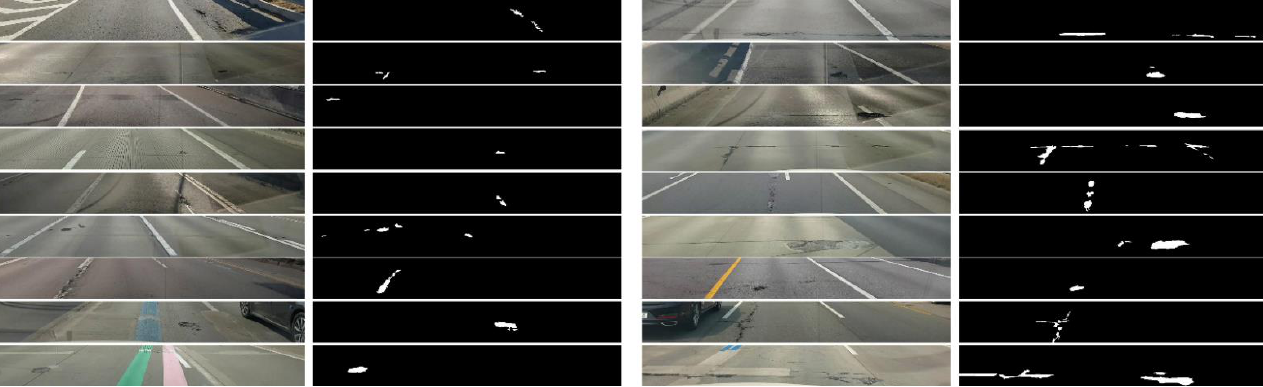
Figure 4. Examples of original and labeled images with road-surface cracks.